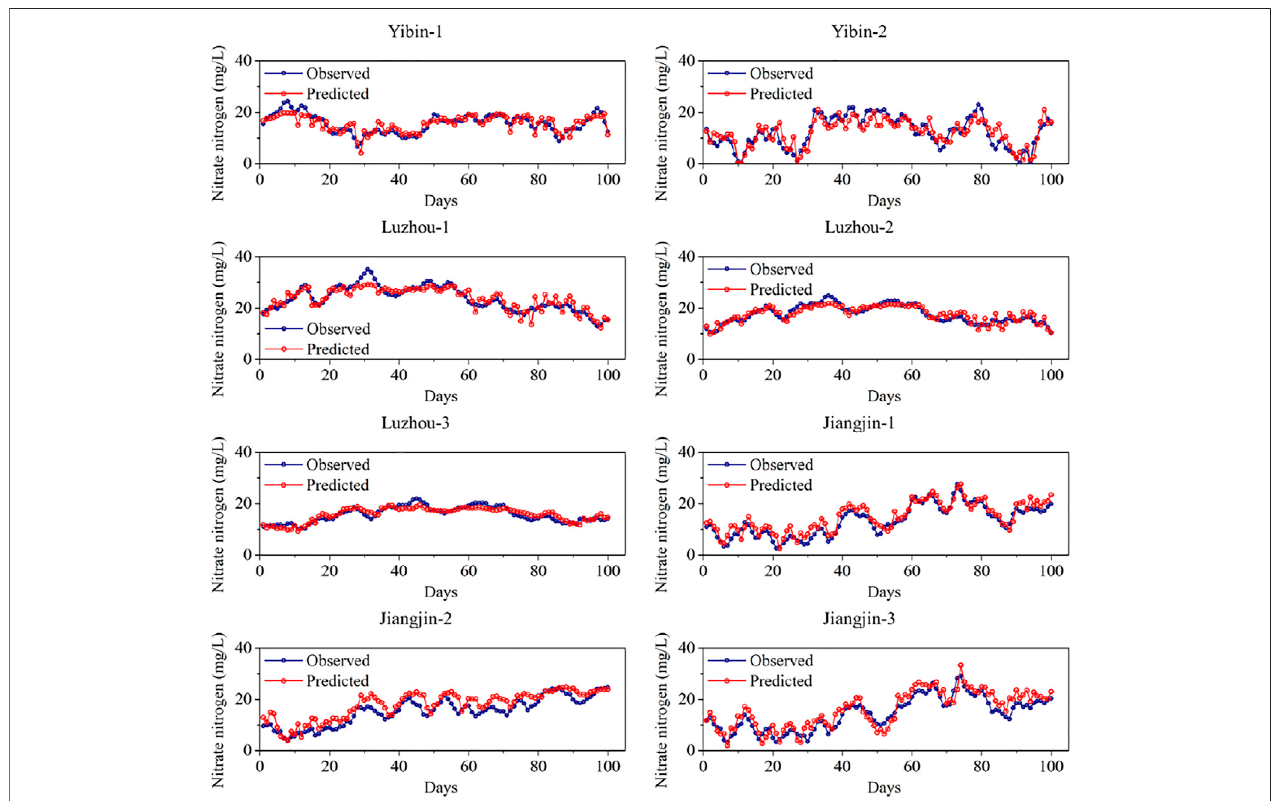
FIGURE 6 | Predicted daily nitrate concentration versus actual observed concentration.